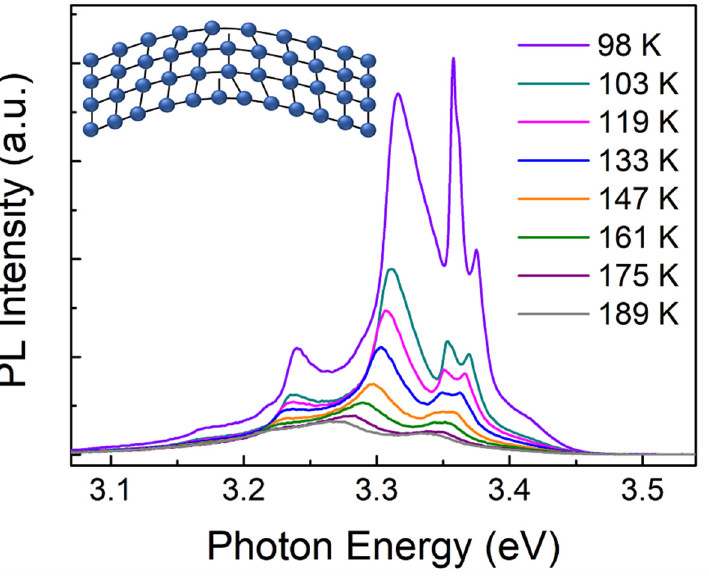
Figure 6. Temperature dependent PL measurements in bending area, inset: the schematic diagram of emerging dangling bounds defect.